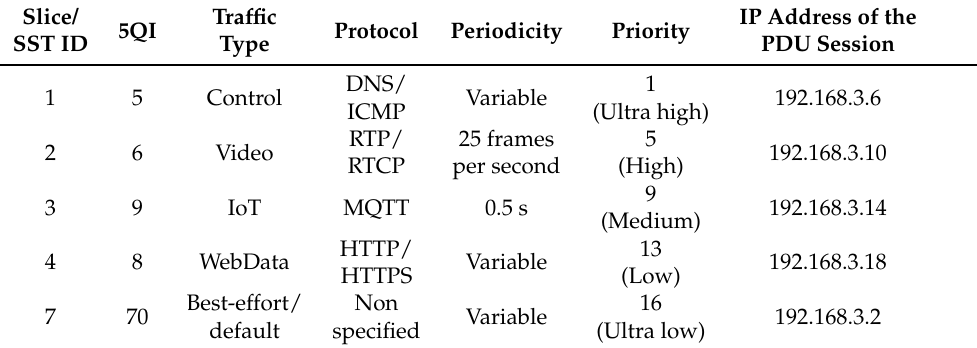
Table 5. Selected traffic per